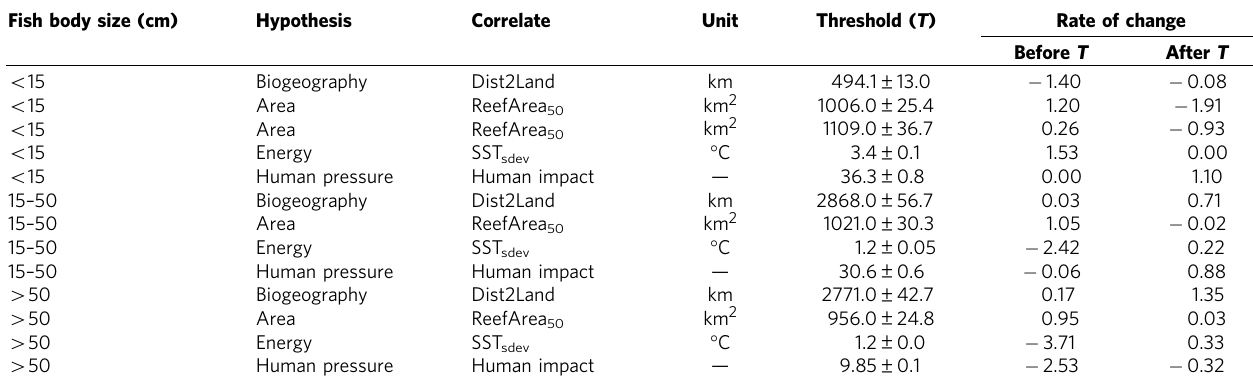
Table 1 | Critical thresholds in the probability of occurrence of fish species of increasing body size in response to biogeography, energy, area-related correlates and human